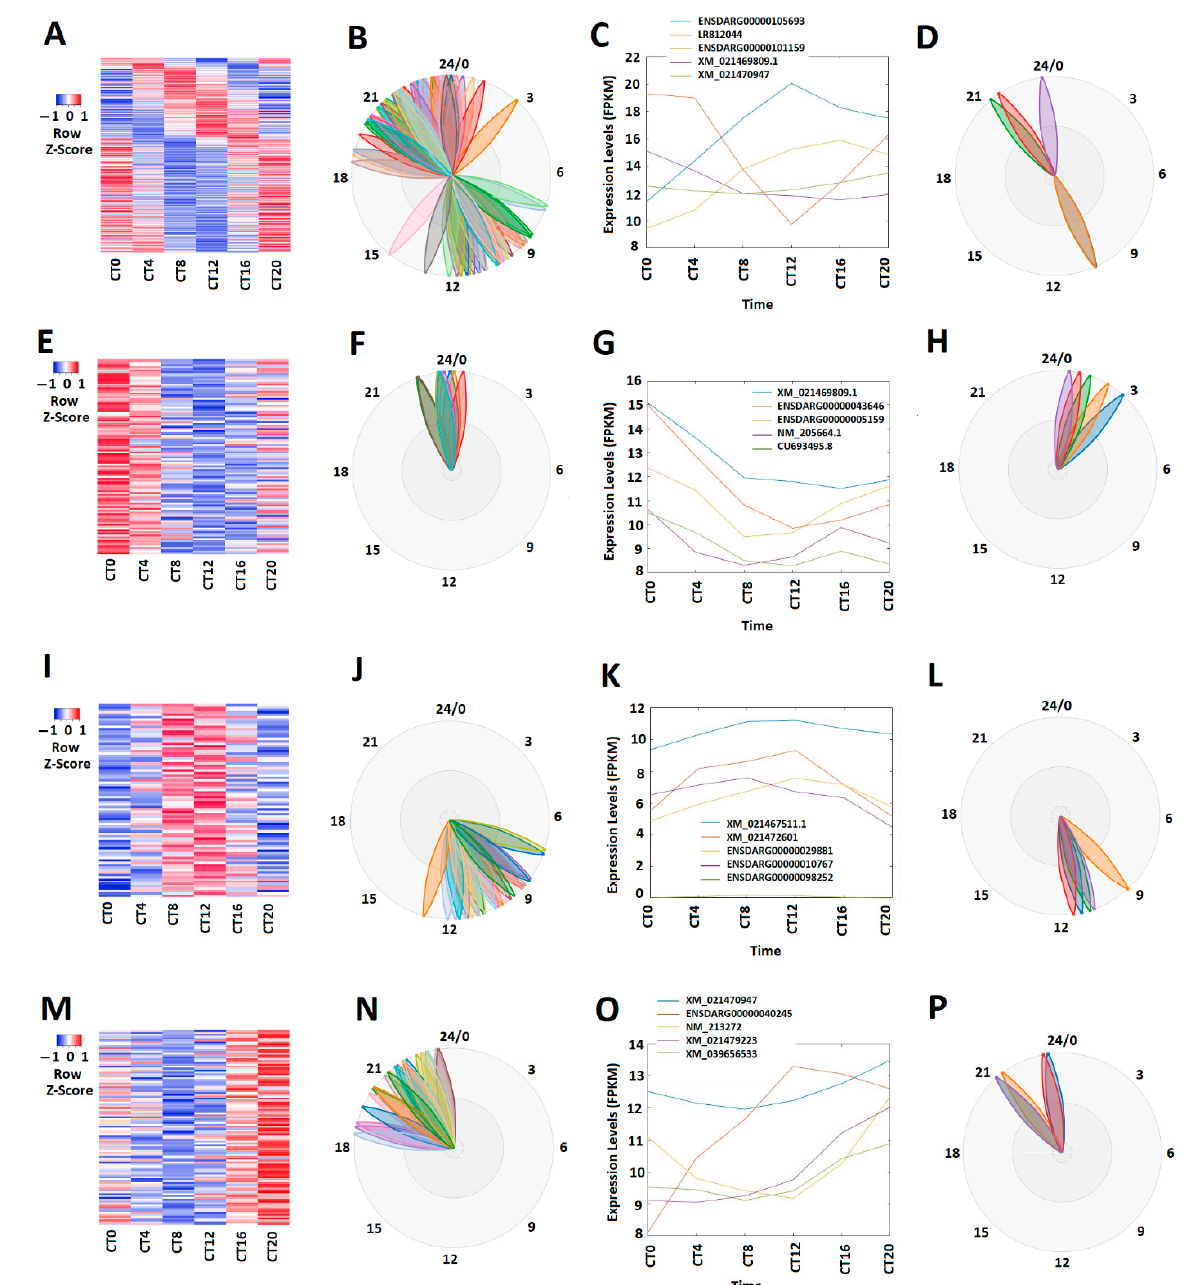
Figure 1. Expression profile analysis of circadianly expressed zebrafish larval lncRNAs under the DD condition. ( A – D ) Analysis of all the 269 circadianly expressed larval lncRNAs under the DD condition. Heat map ( A ) and BioDare2 plots ( B ) of all the 269 circadianly expressed zebrafish larval lncRNAs, expression profiles ( C ) and BioDare2 plots ( D ) of representative lncRNAs. ( E – H ) Analysis of 100 larval morning (CT0 and CT4) lncRNAs. Heat map ( E ) and BioDare2 plots ( F ) of the 100 lar- val zebrafish morning lncRNAs, expression profiles ( G ) and BioDare2 plots ( H ) of zebrafish larval morning representative lncRNAs. ( I – L ) Analysis of 75 zebrafish larval evening (CT8 and CT12) lncRNAs. Heat map ( I ) and BioDare2 plots ( J ) of the 75 larval evening lncRNAs, expression profiles ( K ) and BioDare2 plots ( L ) of larval evening representative lncRNAs. ( M – P ) Analysis of 94 larval zebrafish night (CT16 and CT20) lncRNAs. Heat map ( M ) and BioDare2 plots ( N ) of the 94 larval zebrafish night lncRNAs, expression profiles ( O ) and BioDare2 plots ( P ) of larval zebrafish night representative